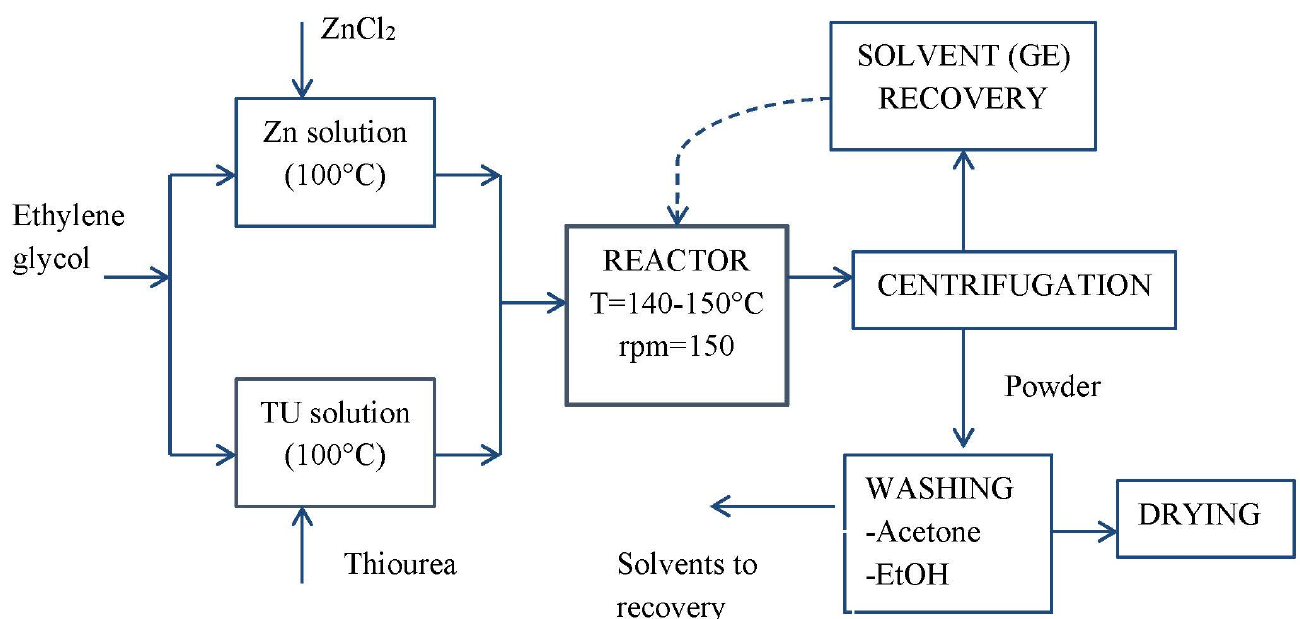
Figure 1. The schematic representation of the ZnS nanopowder synthesis.